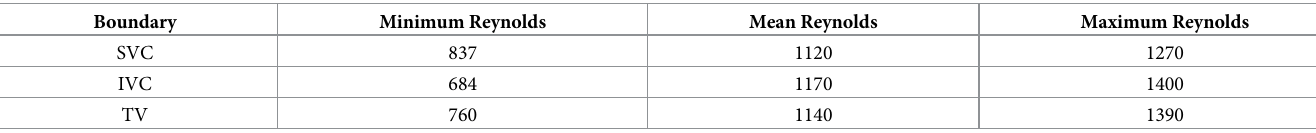
Table 3. Reynolds number study performed for the RA